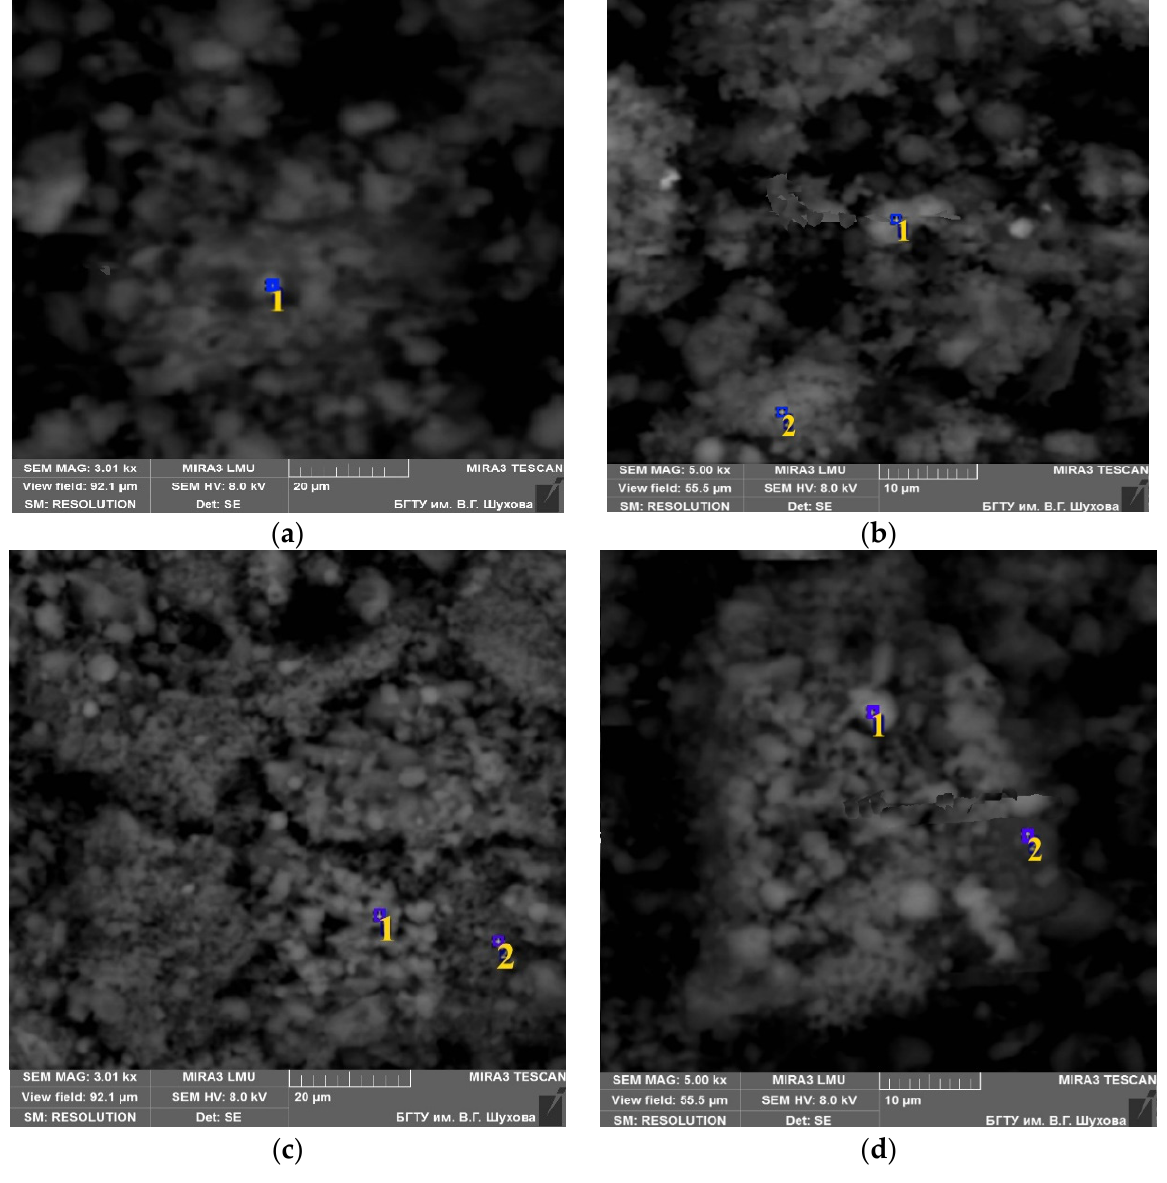
Figure 2. SEM images of initial silicified marl without treatment ( a , b ) and thermally treated at 700 ◦ C ( c , d ). 1 and 2—research EDS points in Figures 3 and